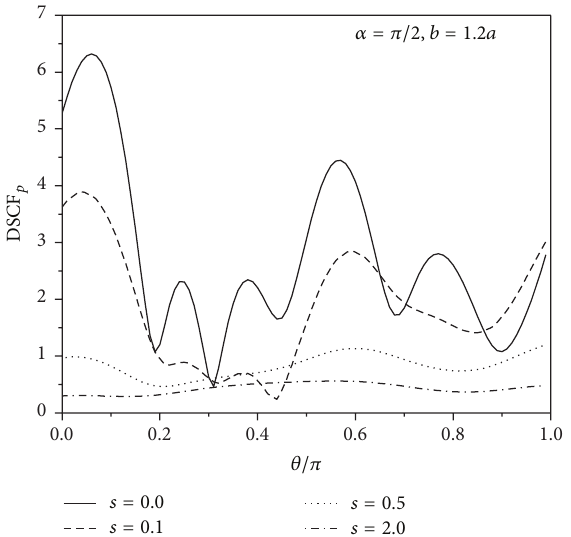
Figure 8: Surface effect on the distribution of DSCF along the middle hole for 𝛽 = 0.001 and 𝑏 = 1.2𝑎